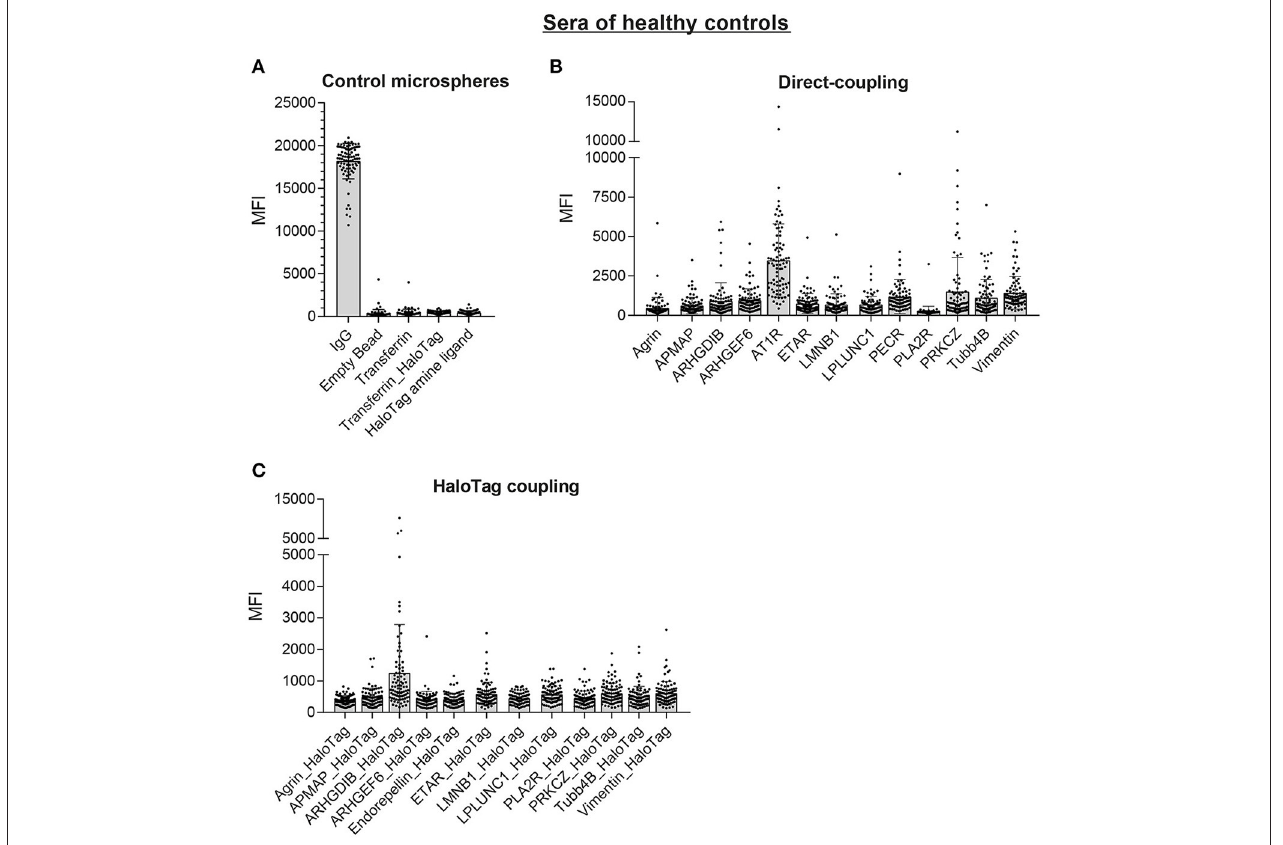
FIGURE 6 | Multiplex non-HLA antibody assay using sera of 87 healthy controls . Shown are the individual MFI values with the mean ± standard deviation (SD) for the positive control microsphere (IgG) and the 4 negative control microspheres (A) , the 13 direct-coupled microspheres (B) , and the 12 HaloTag coupled microspheres (C) .